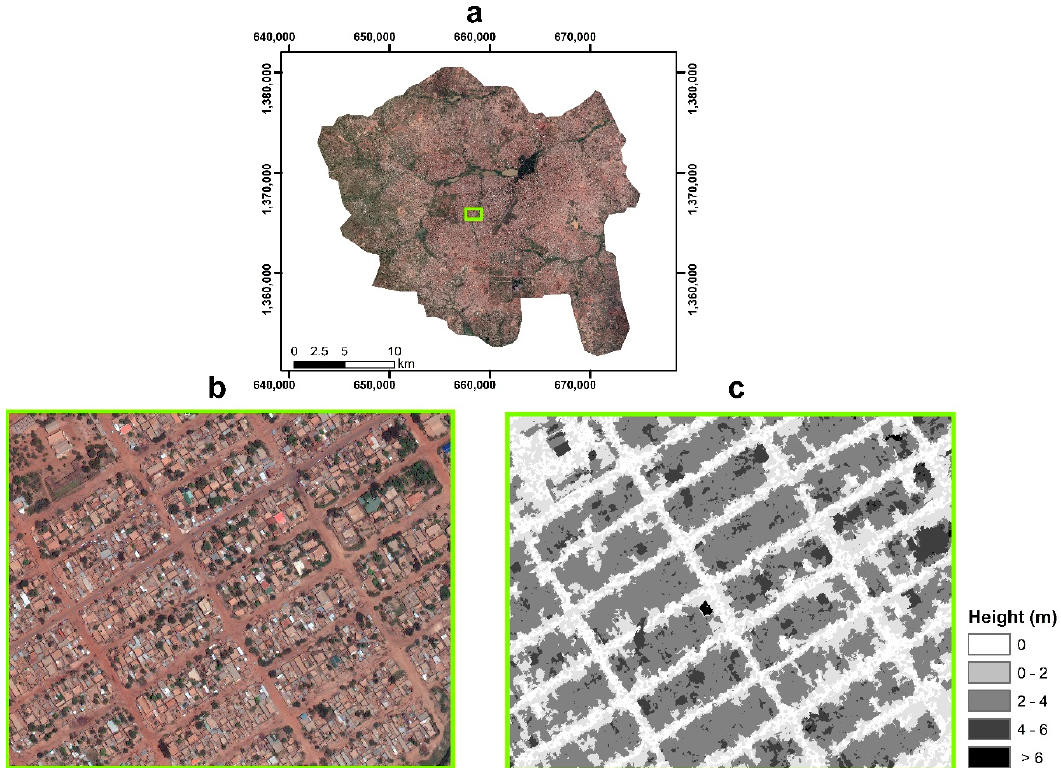
Figure 1. ( a ) Study area extent illustrated from a WorldView-3 RGB composite of Ouagadougou, ( b ) a typical built-up neighborhood of Ouagadougou and ( c ) Normalized Digital Surface Model for the region.